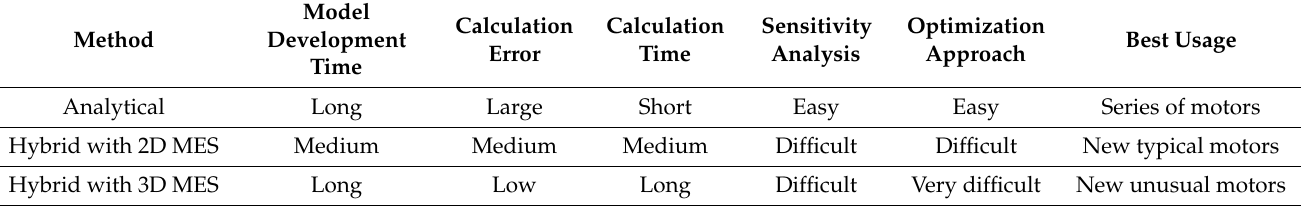
Table 1. Summary of properties of methods used to analyze noise levels in electric